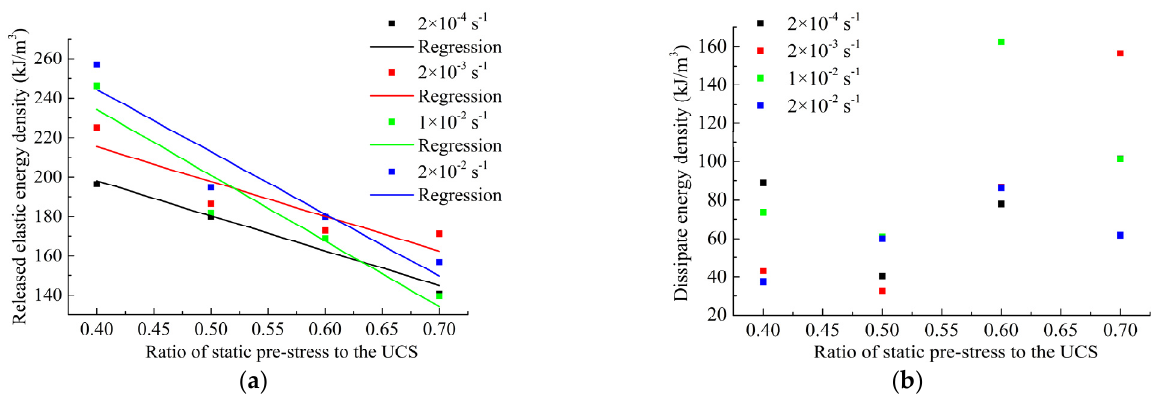
Figure 9. Effect of static pre-stress on ( a ) the released elastic energy density and ( b ) the dissipated energy density.